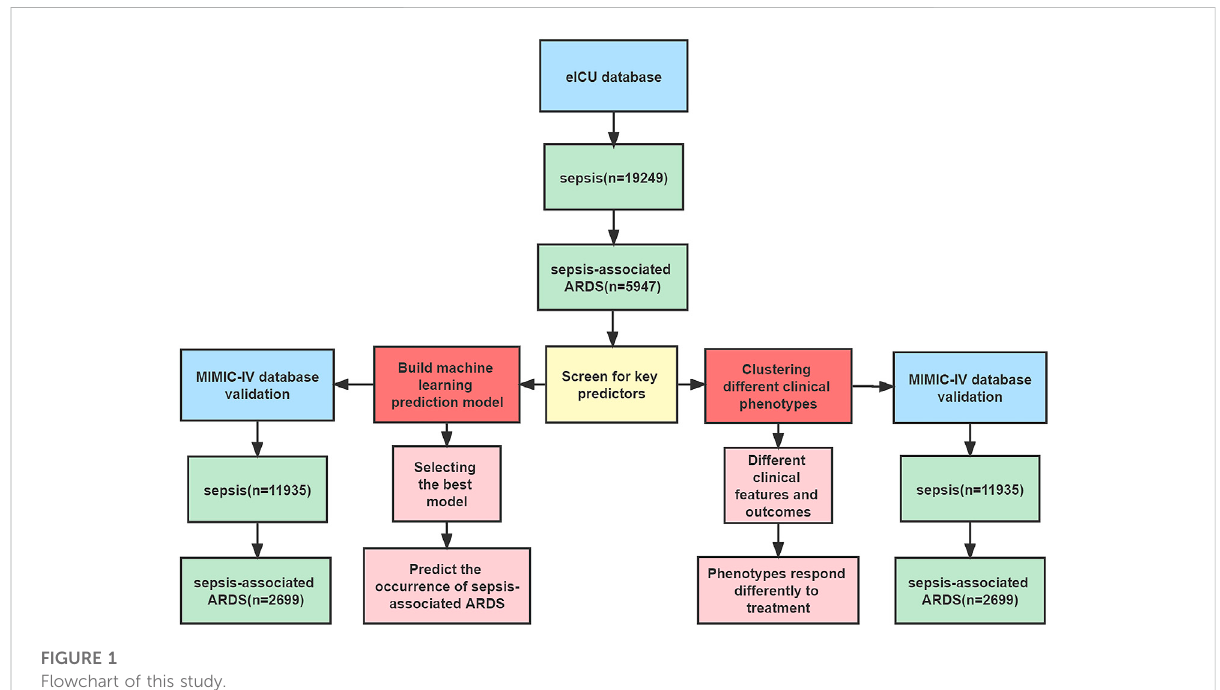
FIGURE 1 Flowchart of this